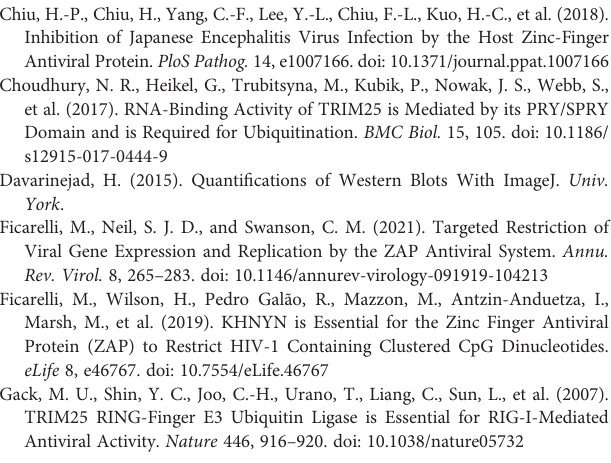
Supplementary Figure 1 | Expression of ZAP and TRIM25 mutants. (A-E) Final transfected DNA amounts for each mutant written below, where 1k = 1 m g of DNA. (A) Western blot of ZAPS zinc fi nger (ZnF) mutants. (B) Western blot of ZAPL ZnF mutants. (C) Western blot of ZAPS CpG RNA binding cavity mutants. (D) Western blot of ZAPL CpG RNA binding cavity mutants. Yellow highlighted cells indicate the selected amount to transfect for subsequent experiments. (E) Western blot of TRIM25 RNA binding mutants. Supplementary Figure 2 | Effect of SINV infection on ZAP and TRIM25 protein expression. (A, B) ZAP KO 293T cells or (C) TRIM25 KO 293T cells were transfectedwith (A) ZAPSRNAbindingmutants, (B) ZAPLRNAbindingmutants,or (C) TRIM25 RNA binding mutants. Lysates were harvested at 0 and 24 h.p.i. with SINV Toto1101/luc infection at an MOI of 0.01 PFU/cell. Data from triplicate wells are representative of two independent experiments Supplementary Figure 3 | Effect of replication-de fi cient SINV infection on ZAP and TRIM25 protein expression. (A, B) ZAP KO 293T cells or (C) TRIM25 KO 293T cells were transfected with (A) ZAPS RNA binding mutants, (B) ZAPL RNA binding mutants, or (C) TRIM25 RNA binding mutants. Lysates were harvested at 0 and 6 h.p.i. with SINV Toto1101/luc:ts6 infection at an MOI of 1 PFU/cell. Data from triplicate wells are representative of two independent experiments. Supplementary Figure 4 | Sensitivity of the fi re fl y luciferase control RNA to ZAP. (A, B) ZAP KO 293T cells or (C) TRIM25 KO 293T cells were transfected with (A) ZAPS RNA binding mutants, (B) ZAPL RNA binding mutants, or (C) TRIM25 RNA binding mutants, transfected with fi re fl y luciferase (Fluc) RNA, and lysed 4 hours post-RNA transfection for measurement of luciferase activity. Data from triplicate wells are representative of two independent experiments. Asterisks indicate statistically signi fi cant differences as compared to (A, B) ZAP WT or (C) TRIM25 WT within each subset of RNA binding mutants (by one-way ANOVA and Dunnett ’ s multiple comparisons test: *p<0.05; **p<0.01; ***p<0.001). Unlabeled comparisons are not signi fi